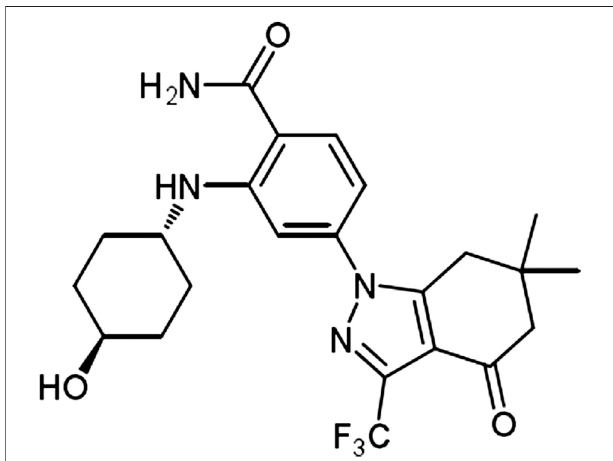
FIGURE 2 | The chemical structure of